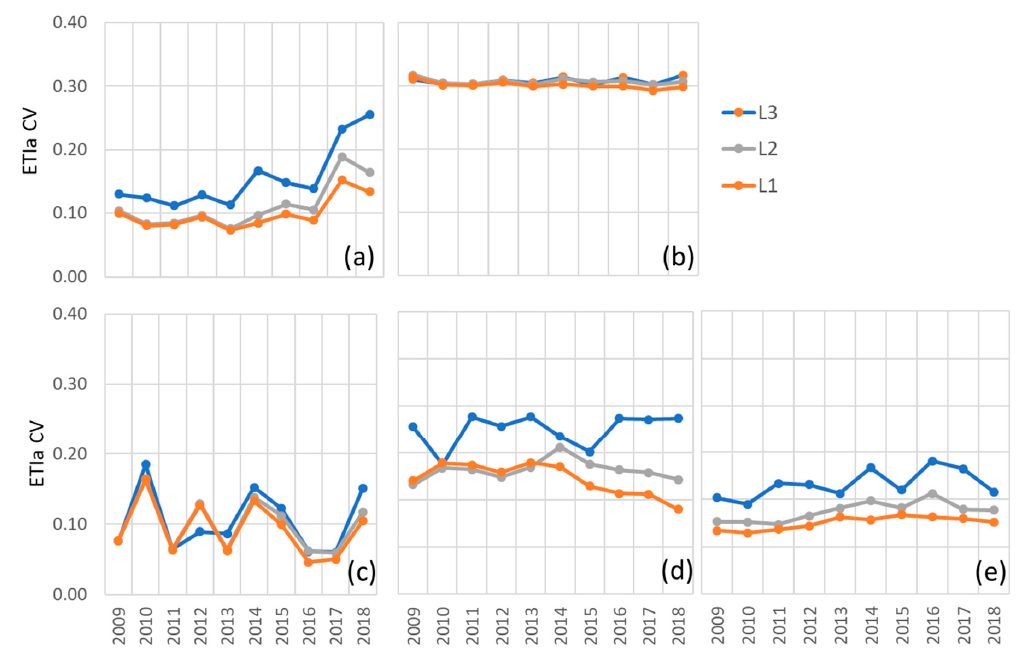
Figure 4. Annual intra-plot ETIa CV in each scheme: ( a ) Wonji, ( b ) Metehara, ( c ) ODN, ( d ) Koga, and ( e ) Zankalon.